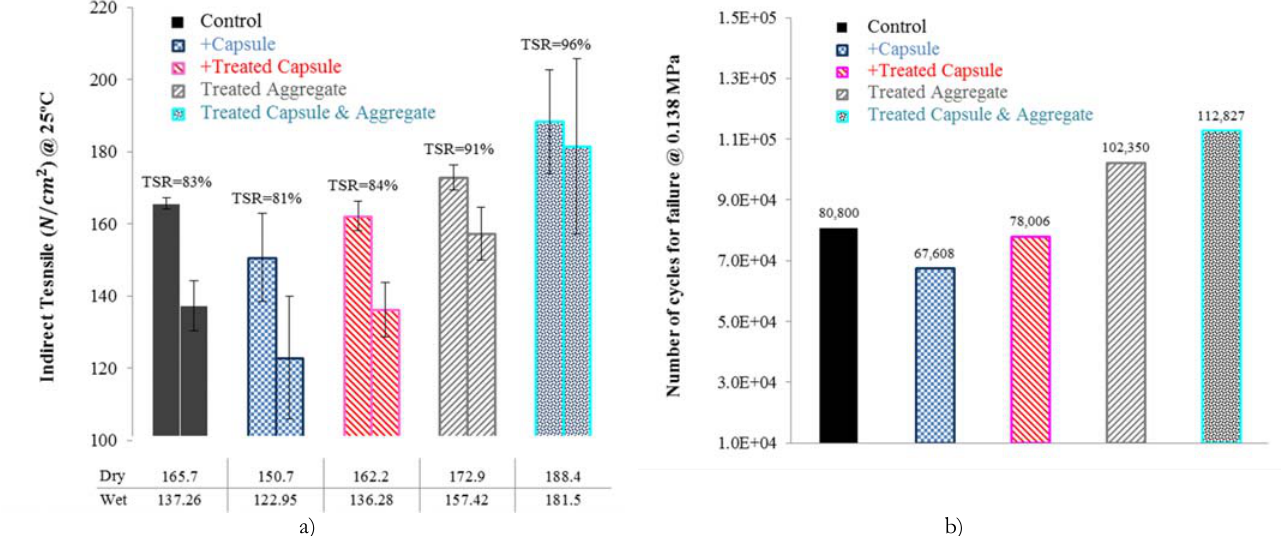
Figure 9: The results of ITS and ITF tests. a) The indirect tensile strength of specimens; b) Number of cycles required to to break